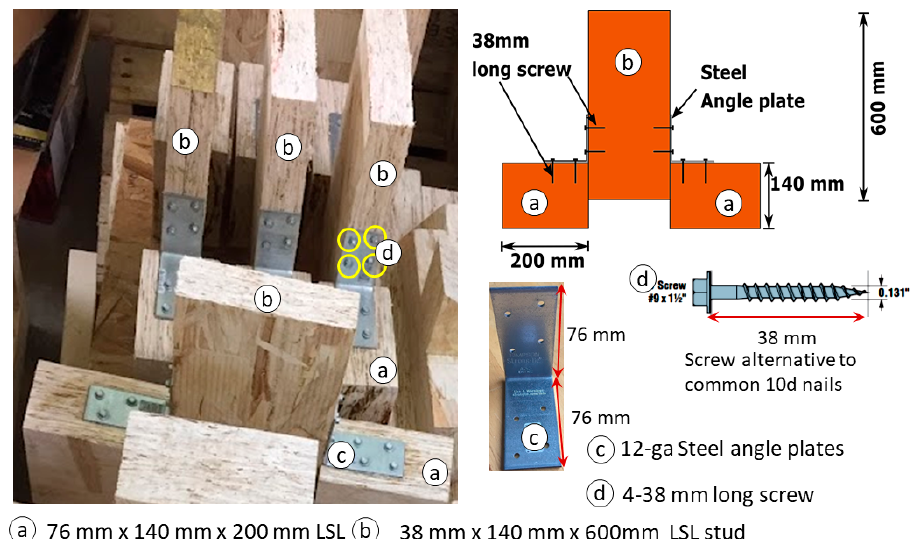
Figure 10. Connection-E specimen.